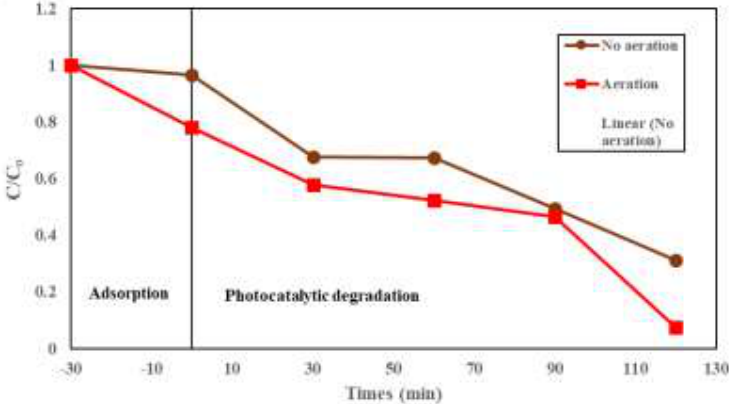
Figure 6: Effect of aeration on LaFeO3 of adsorption and photocatalytic degradation HA (pH = 6, HA = 10 mg/L, Catalyst dosage = 0.1 gram, contact time = 120 minutes, air flow rate of 0.62 L. min-1.